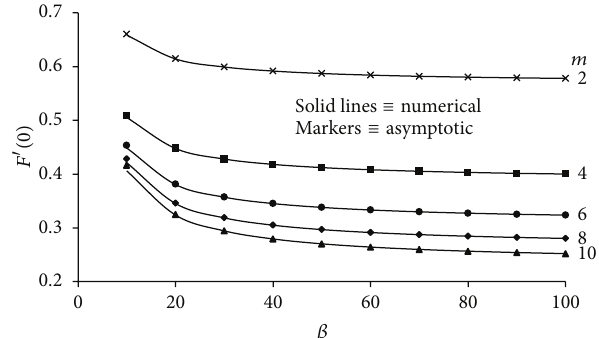
Figure 2: Radial surface shear 𝐹 󸀠 (0) versus 𝛽 , with different values of 𝑛 ; 𝑚 = 1 , 𝑉 𝑠 = 0